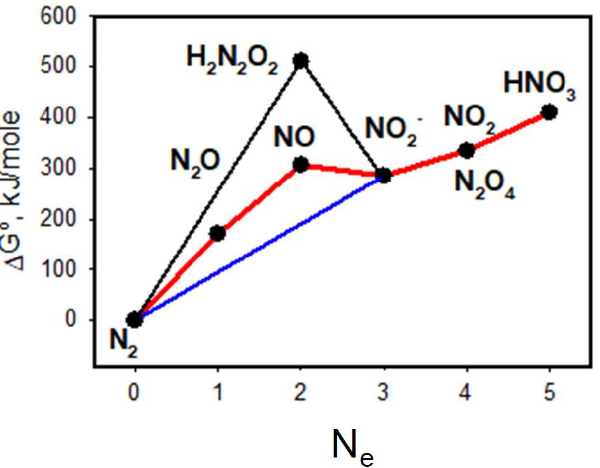
Figure 2. Gibbs energy of N 2 multielectron oxidation at the CAPPJ/water interface; N e is the number of electrons. The red line shows the most probable pathway of nitrogen oxidation to HNO 3